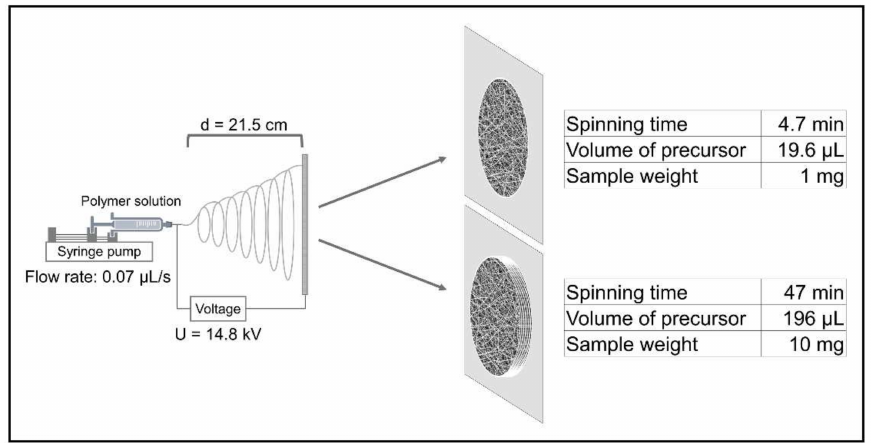
Figure 1. Electrospinning setup and preparation of two samples of different weights for